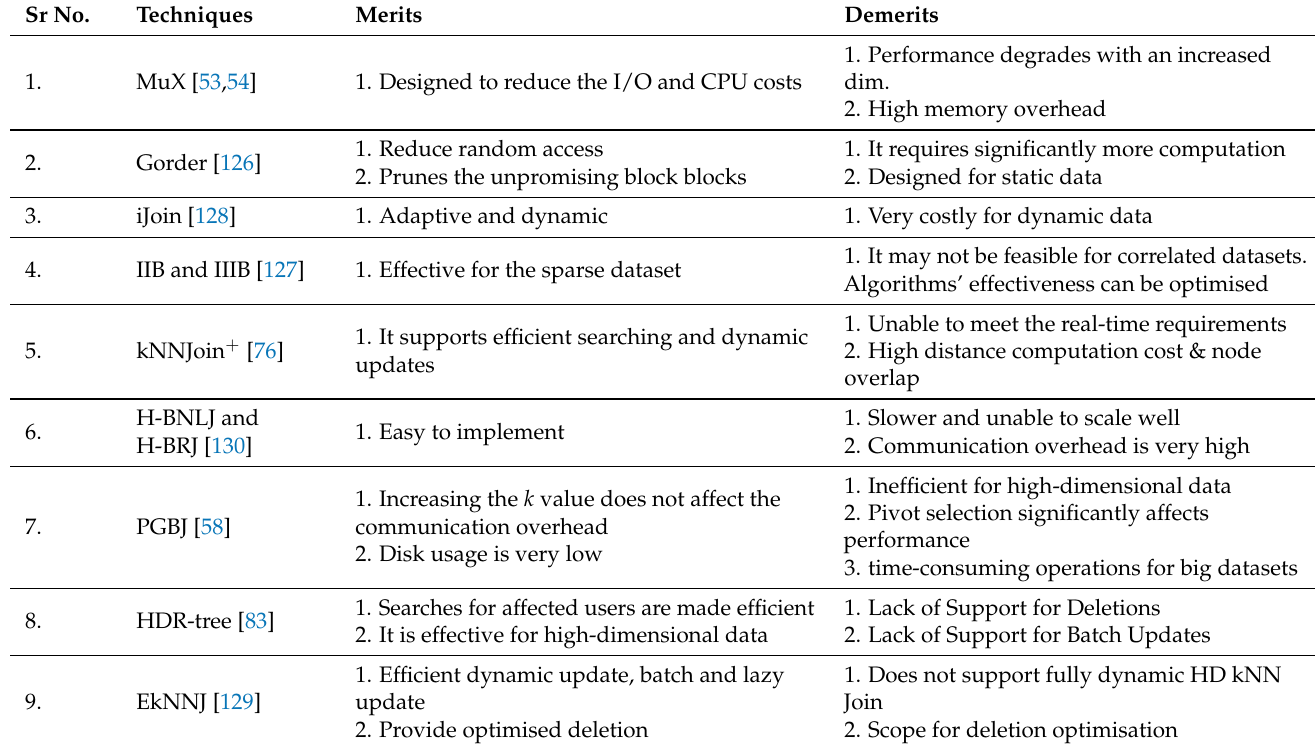
Table 6. Comparative Study of kNN Join